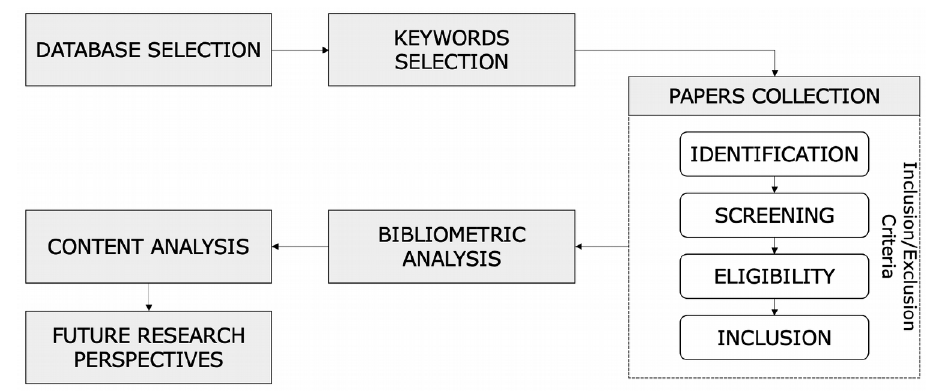
Figure 1. Research Methodology Scheme